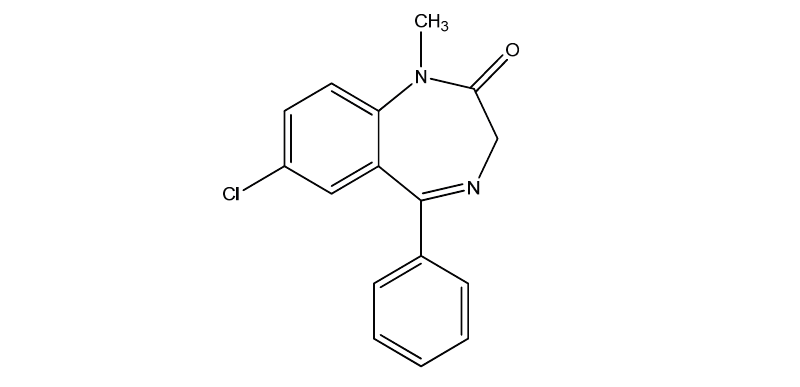
Figure 25. Diazepam